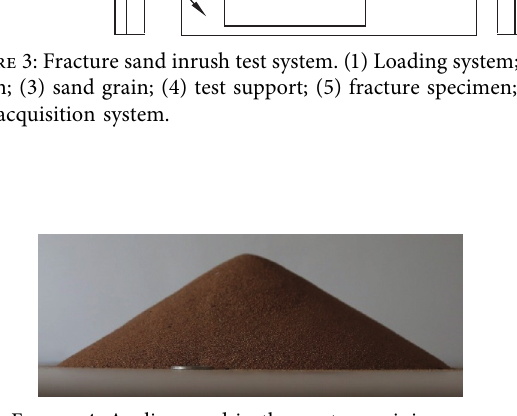
Figure 4: Aeolian sand in the western mining